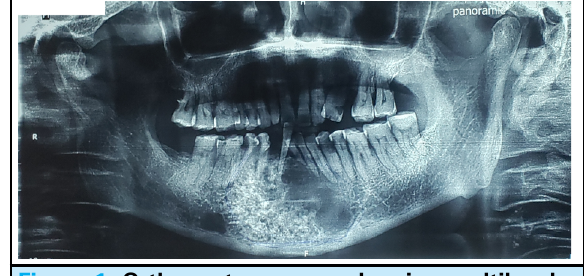
Figure 1. Orthopantomogram showing multilocular radiolucency with a mixed radiographic pattern of honeycomb appearance interspersed with soap bubble pattern in the right mandible.